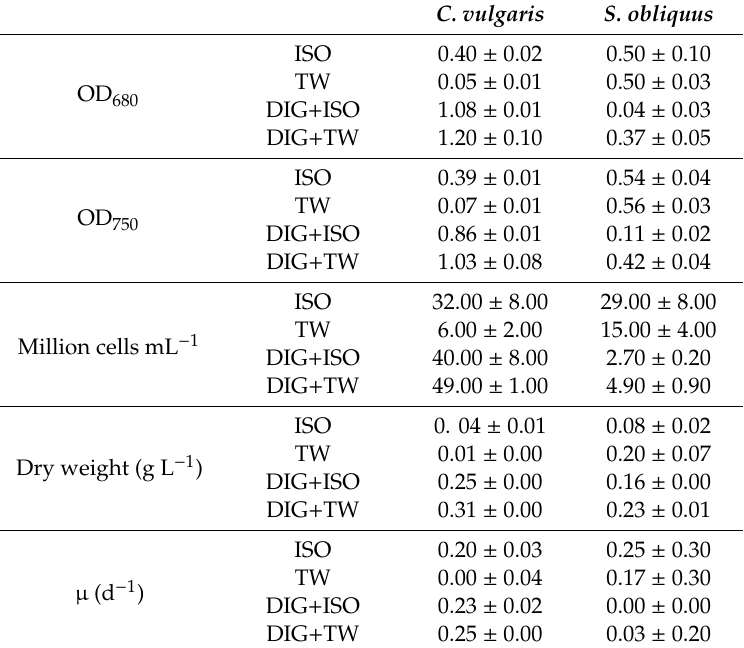
Table 3. Cellular count, OD, dry weight and growth rate in stationary phase for C. vulgaris and S. obliquus in control conditions (ISO and TW) and test conditions (DIG + ISO and DIG + TW diluted 1:5) ( n =